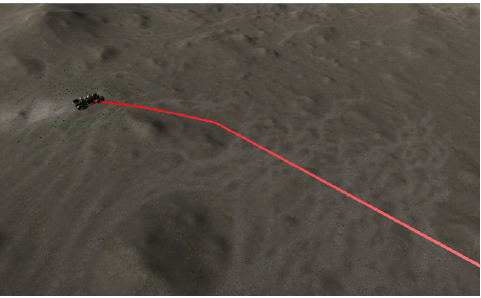
Figure 11. Schematic diagram of the safe return route.